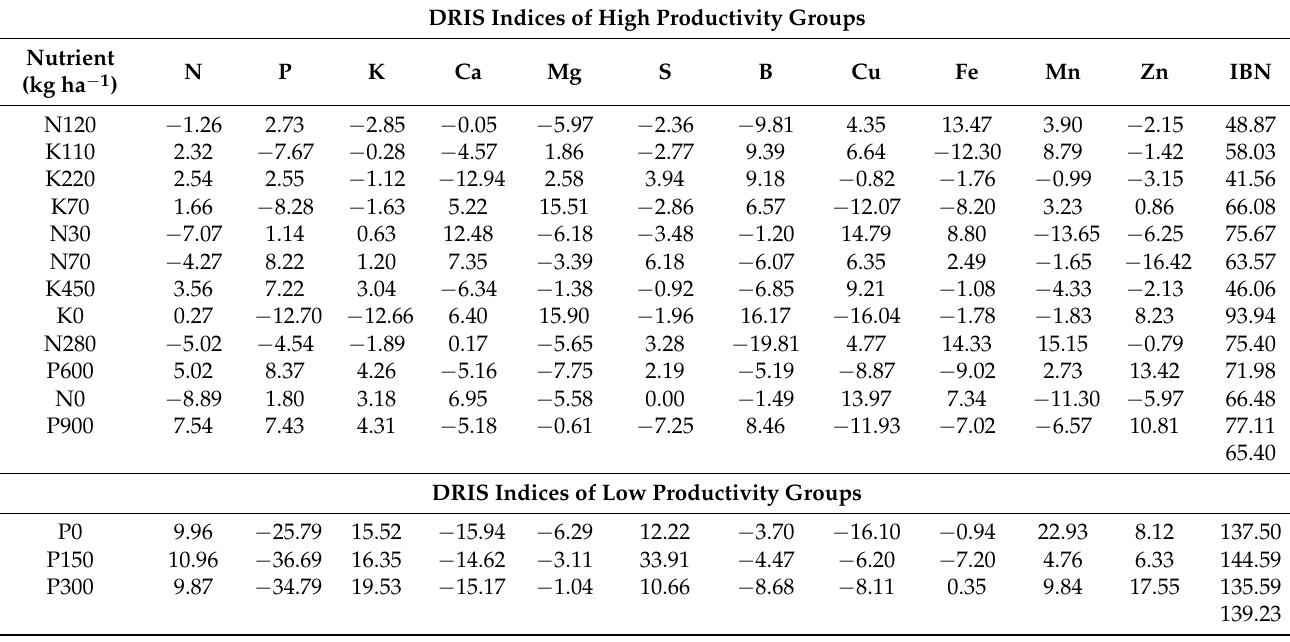
Table 2. Diagnosis and recommendation integrated system (DRIS) indices for macronutrients and micronutrients in